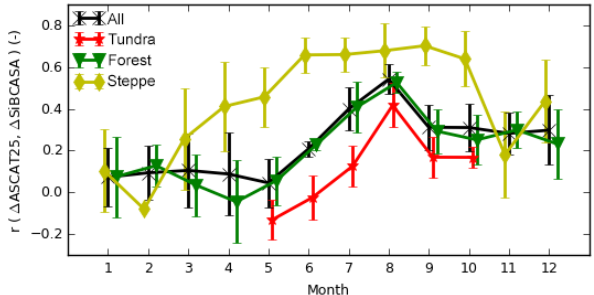
Figure 3. The seasonal variation of the spatial correlation coef- ficient of SiBCASA and ASCAT soil moisture for all grid cells (black x), tundra cells (red *), forest (green triangles), and steppe (brown diamonds). The errorbars indicate the variation between the years